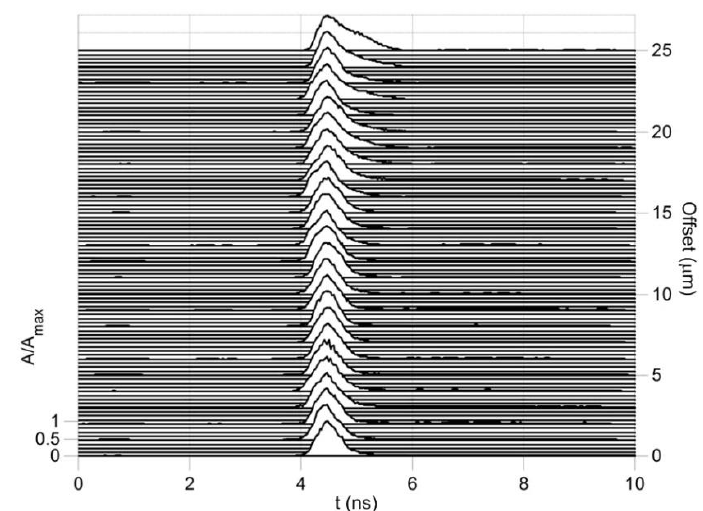
Figure 14. LOMF 100/125 DMD map at wavelength λ = 1310 nm under the reference Gaussian pulse FWHM = 340 ps over 0…25.0 μm offset range via 1.0 μm interval.